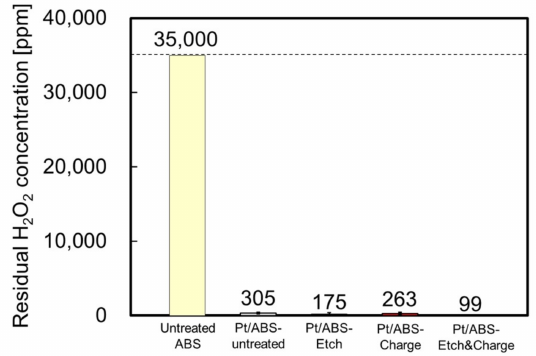
Figure 6. Catalytic activity of the untreated ABS and Pt/ABS samples with various pretreatment: residual H 2 O 2 concentration after immersion for 360 min.